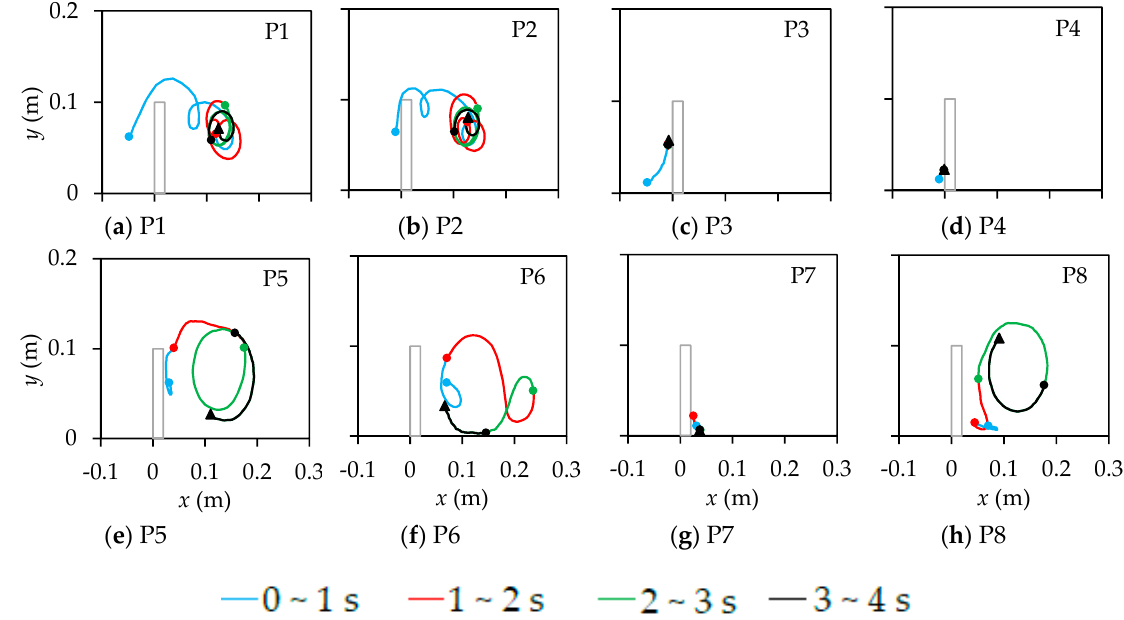
Figure 8. Trajectories of eight particles from 0 ~ 4 s: Blue line (0 ~ 1 s), red line (1 ~ 2 s), green line (2 ~ 3 s) and black line (3 ~ 4 s)